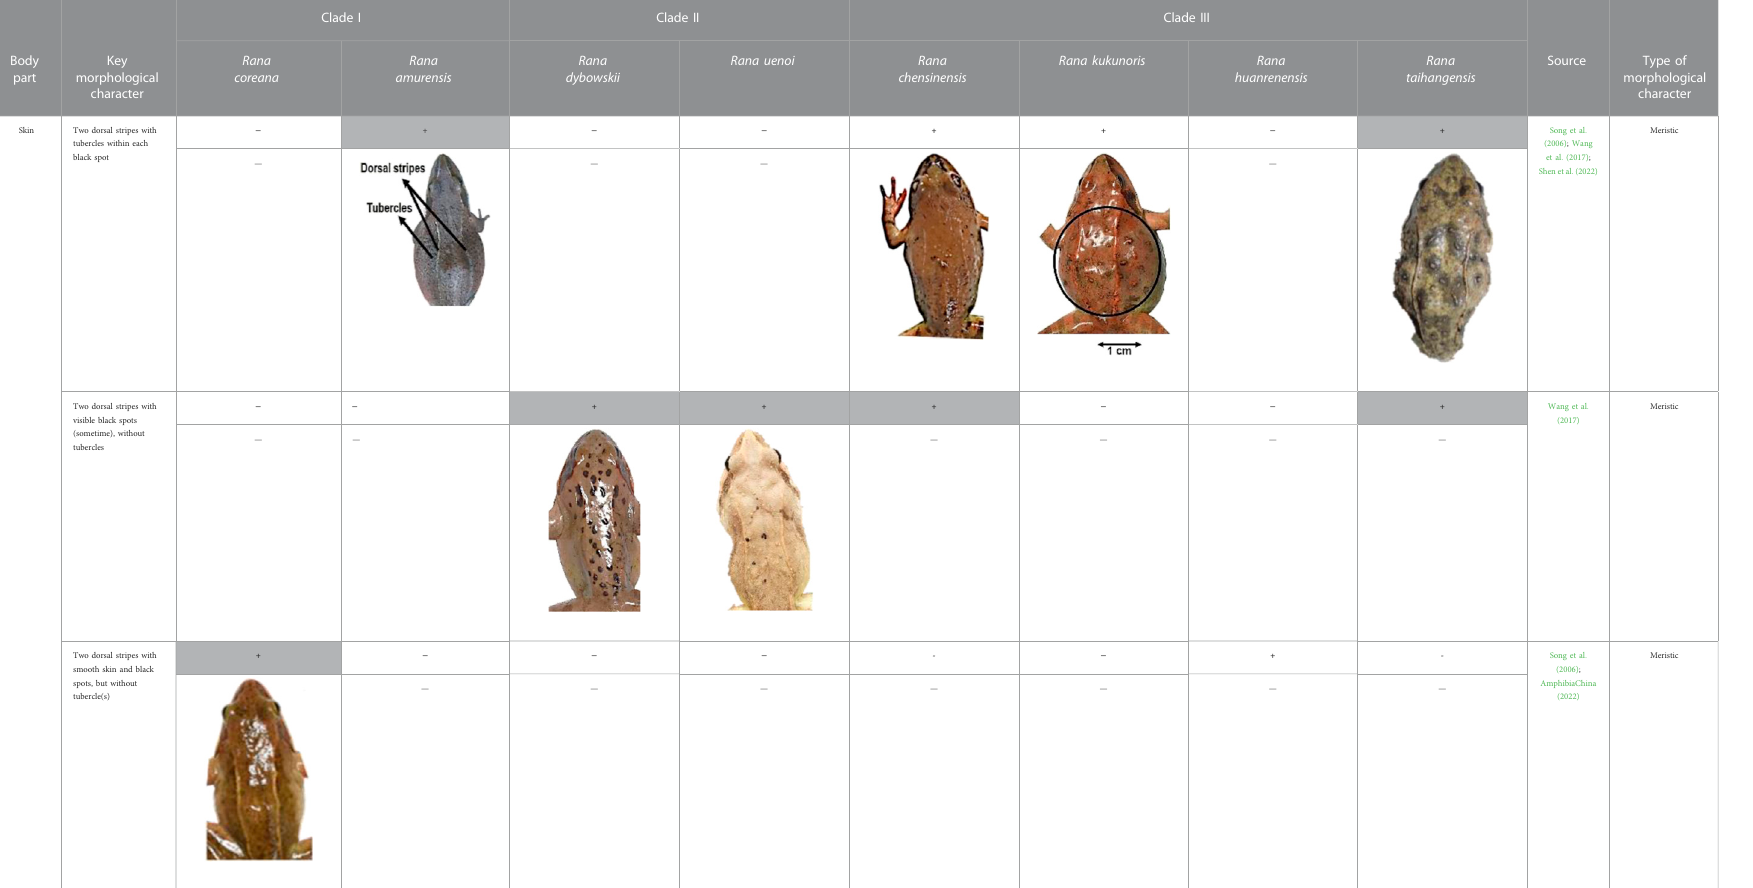
TABLE 1 Identi fi cation key and comparison of 40 morphological characters between eight species of northeastern Asian brown frogs (genus Rana ) recorded from the literatures and online databases of amphibians: AmphibiaWeb (https://amphibiaweb.org)andAmphibiaChina (https://www.amphibiachina.org/).The boxescoloured ingreyandmarkedwithsymbol(+)indicate thepresence ofthecharacter inthespecies andthe colourless boxes marked with symbol ( − ) indicate the absence of the character in the species, OR, the absence of de fi nitive information but matching with at least a few individuals of the species. The symbol (?) indicate the lack of information about the speci fi c morphological character. Coloration outside of the breeding season is not speci fi ed as the trade is limited to the breeding season when body condition makes frogs more suitable for human consumption. The comparison of morphological characters and classi fi cations of Rana into clades I, II and III in the table are adapted from the operational taxonomic units (OTU) based on the 16S rRNA phylogeny of Othman et al. (2022), where R. chensinensis matches with OTU 7 and R. taihangensis matches with OTU 1 and 2, following Shen et al. (2022).